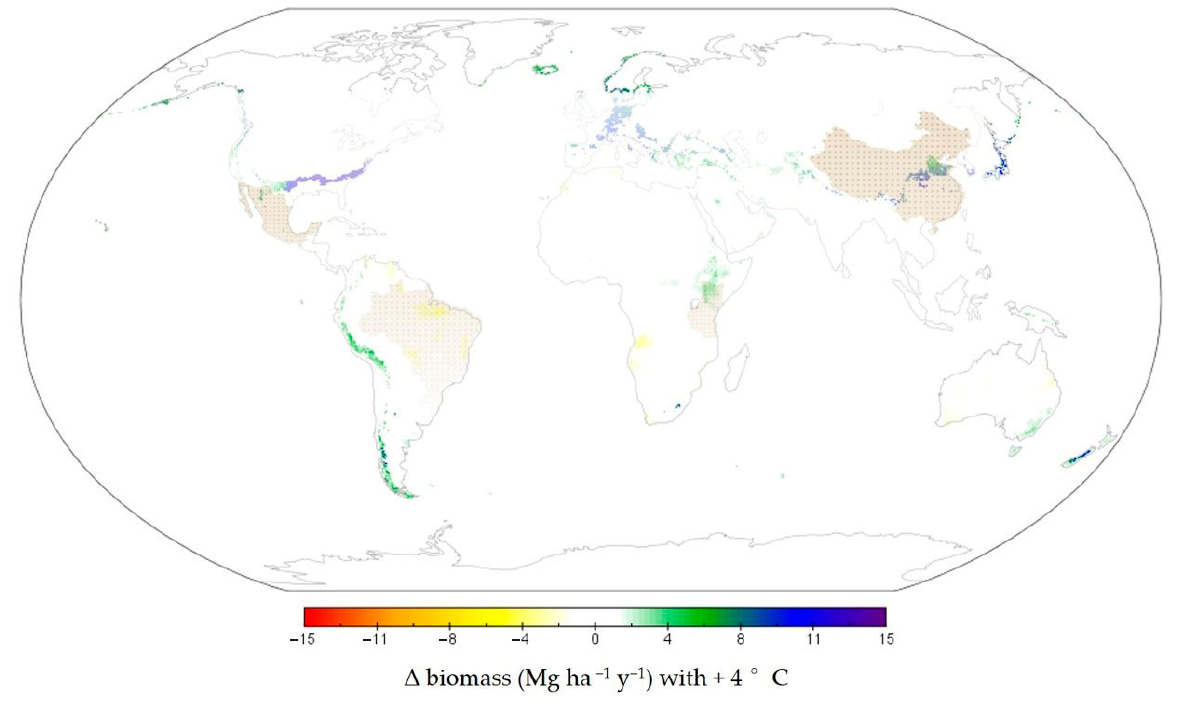
Figure 4. Five nations with greatest production of Agave crops for fiber (dotted brown) and expected change in potential biomass production of Agave americana with climate change as predicted with +4 °C warming (modified from [14]).